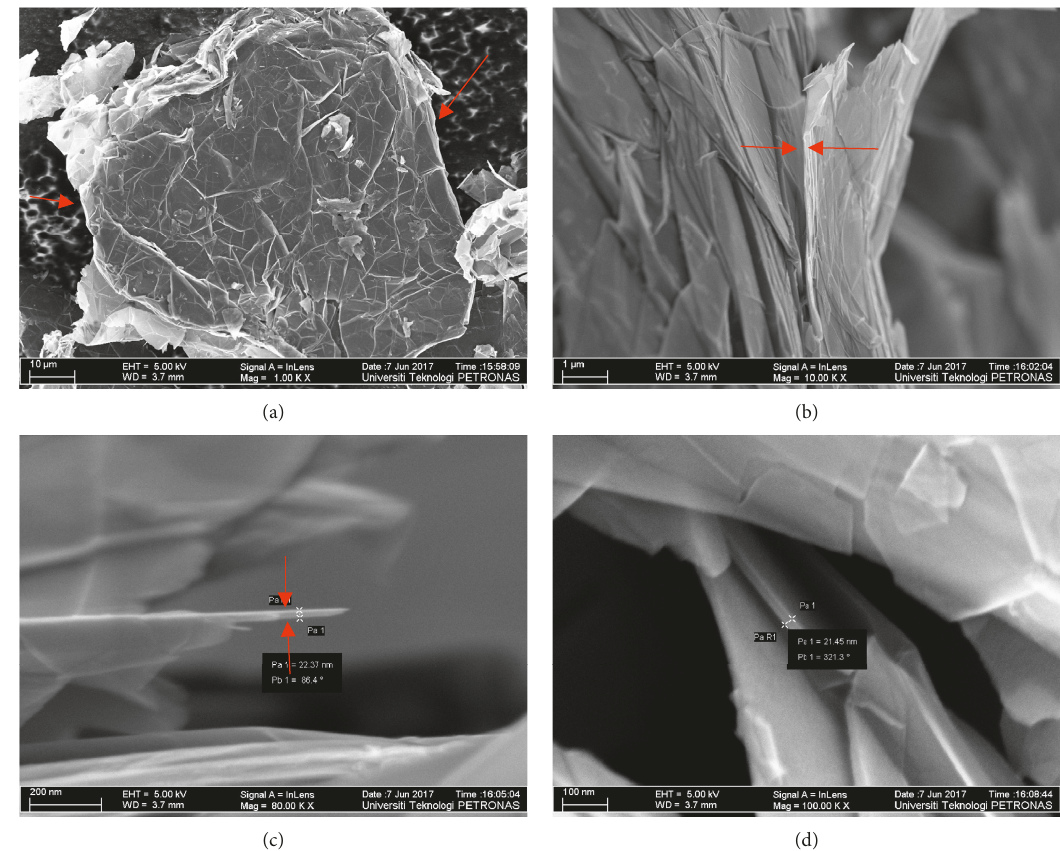
Figure 3: Morphology of graphene nanoplatelets as seen under